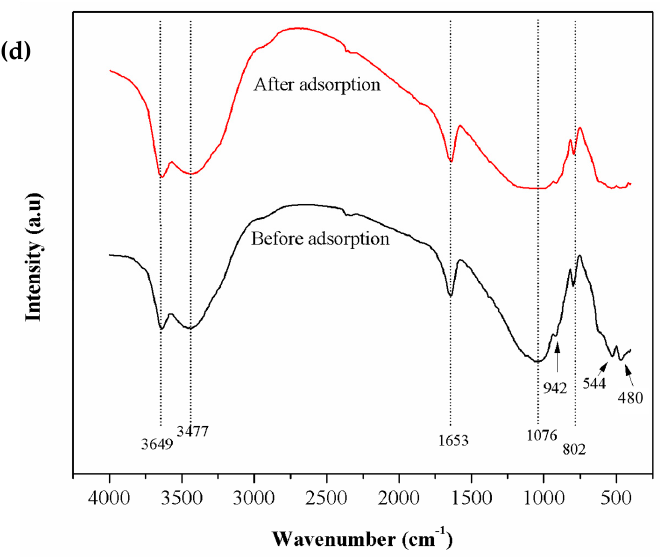
Figure 1. SEM micrographs of ( a ) chitosan, ( b ) bentonite, and ( c ) chitosan-coated bentonite (CCB) at